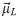
Authorship recognition performance using LLNA.a) Canonical analysis performed for the authorship recognition task using the five books from the authors of the classification-dataset using partial lemmatization. For this plot was used rule B2478-S25 and the Lempel-Ziv distribution μ→L as a feature vector. b) Confusion matrix using kNN method achieved by the best classification rate. Each cell shows the number of correct predicted instances, where nonzero elements are indicated. c) Comparison of the accuracy obtained by the proposed method treating the authorship verification as a one-class classification problem. The accuracy was calculated as the average and standard deviation for the classification of five books of an author A against five books from unknown authors X, using three different classifiers.